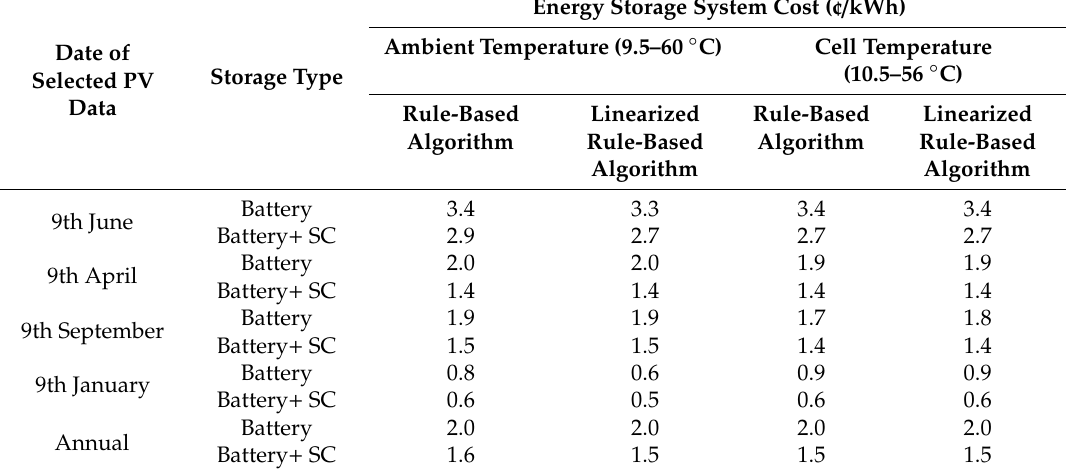
Table 3. Energy storage cost comparison